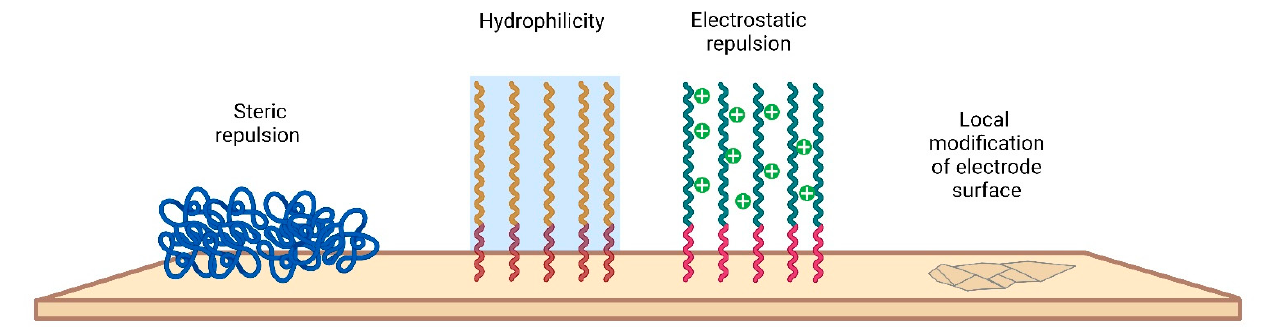
Figure 7. Different antifouling approaches for electrode surfaces.